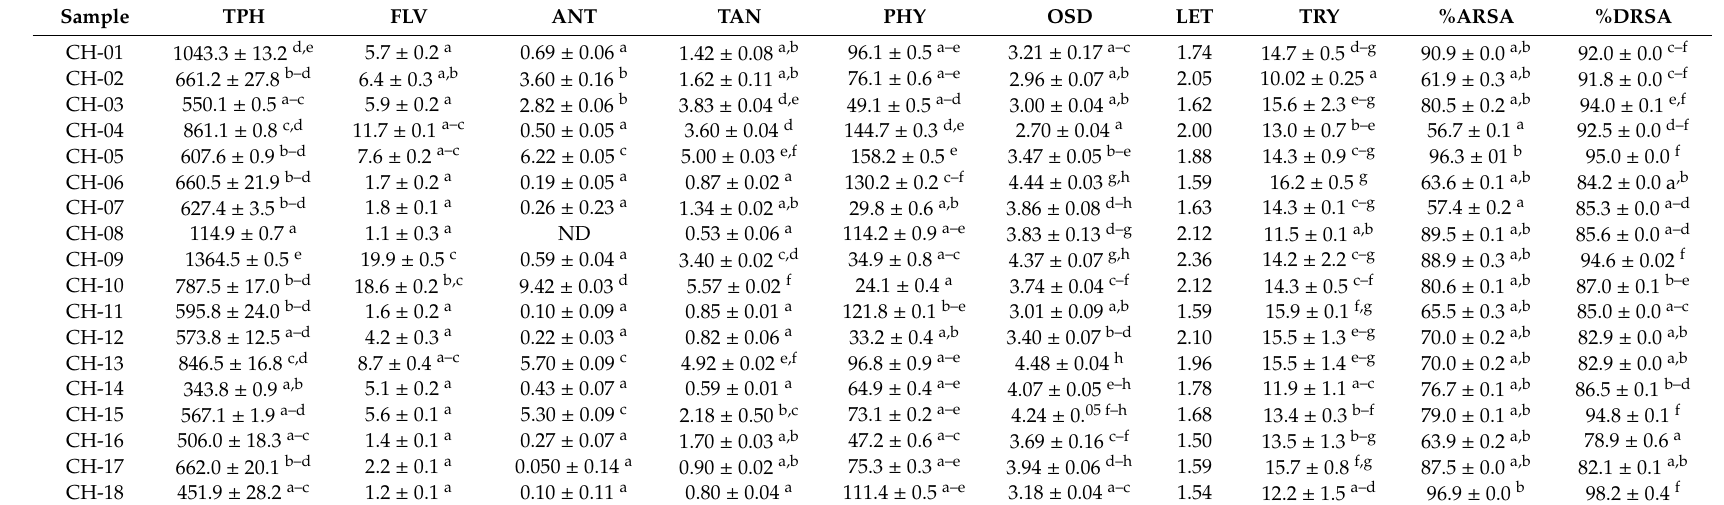
Table 3. Total phenolic (TPH), flavonoid (FLV), anthocyanin (ANT), tannin (TAN), phytic acid (PHY), oligosaccharide (OSD), lectin (LET), trypsin inhibitory activity (TRY) content, and radical scavenging activity (%ARSA, %DRSA) from Phaseolus accessions grown in the Mayan